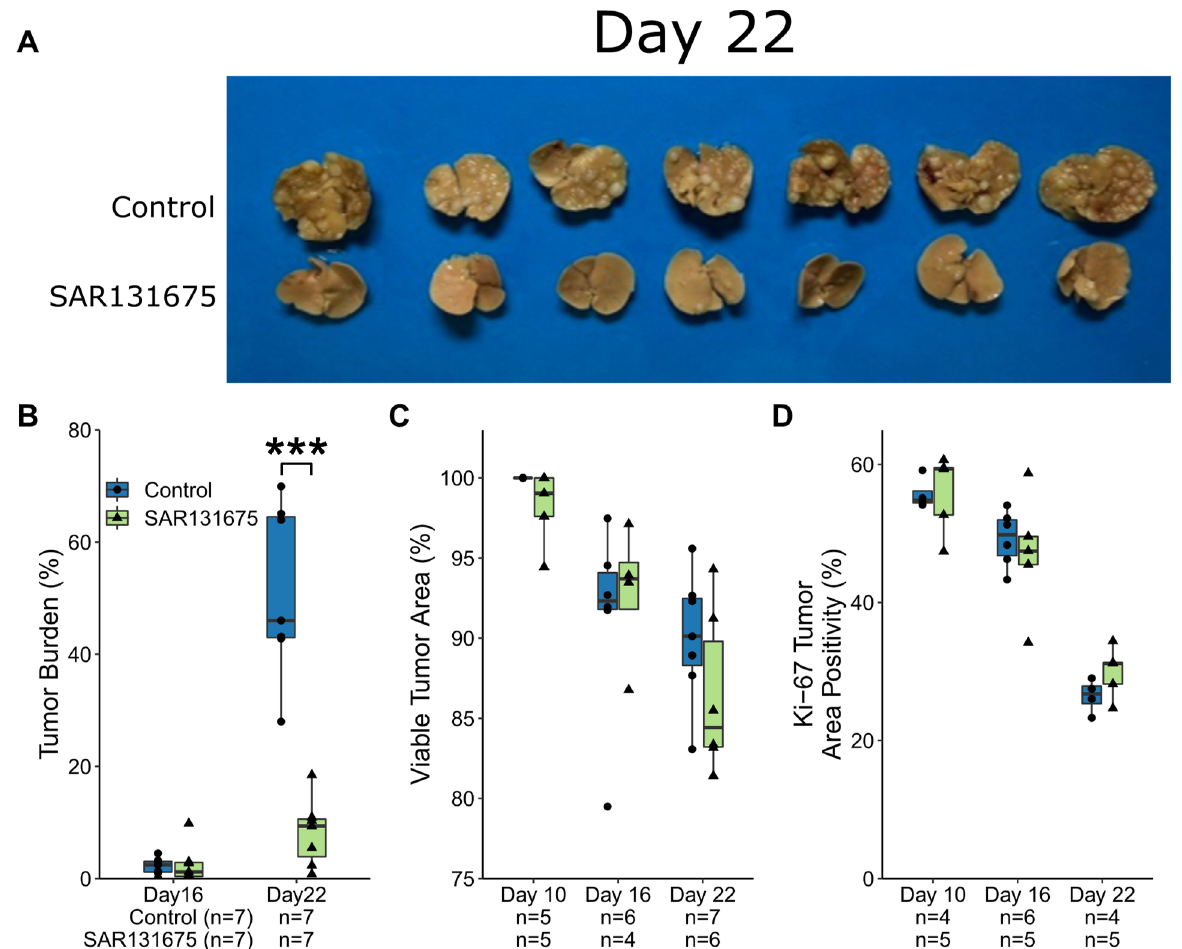
Figure 1. SAR13675 dramatically reduced CRLM tumor burden. ( A ) images of livers collected on Day 22. ( B ) Tumor burden as a percentage of total liver area. ( C ). Viable tumor area as a percentage of total tumor area. ( D ) Ki67 positive tumor area as a percentage of total tumor area. Significance is indicated by * while non-significance is unmarked (*** p < 0.001).